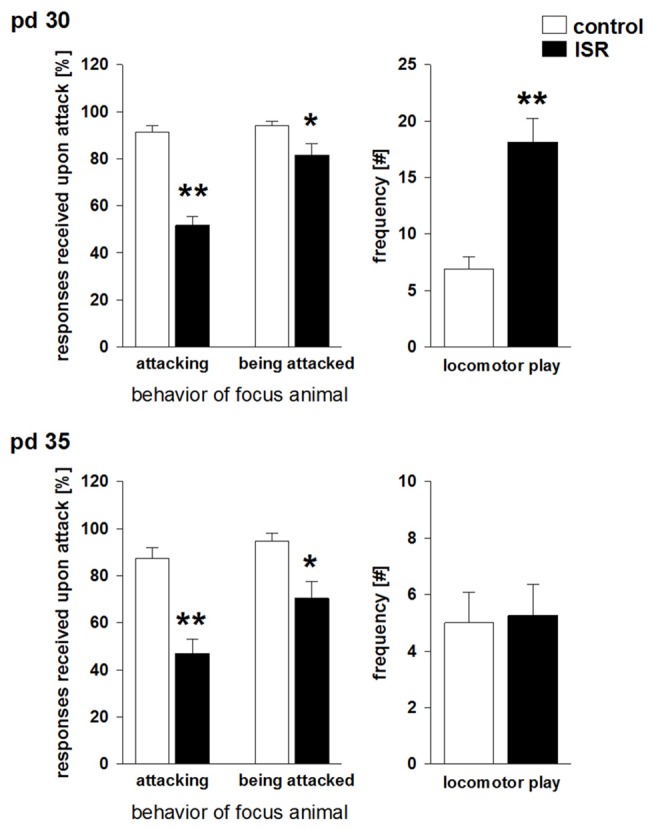
Social play behavior during adolescence on pd 30 and pd 35 in Wistar females subjected to adequate (control) or ISR conditions. The probability of a defensive response received by the play partner after an attack by the focus animal was significantly reduced in females of the ISR condition on both time points. In addition, ISR Wistar rats also responded significantly less when being attacked by the play partner than controls which was further reduced on pd 35. Locomotor play was significantly increased in ISR animals compared to control rats only on pd 30. Data are indicated as means ± SEM (control: n = 9; ISR: n = 8; **P ≤ 0.001; *P ≤ 0.05).